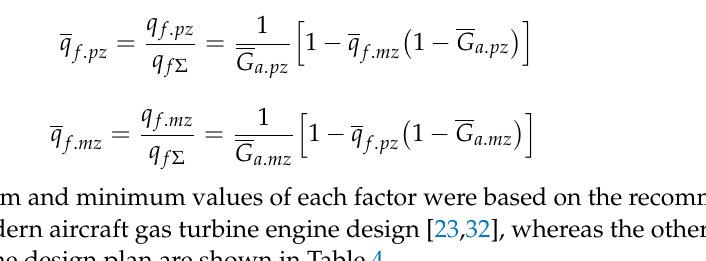
Table 4. Factors for fractional factorial